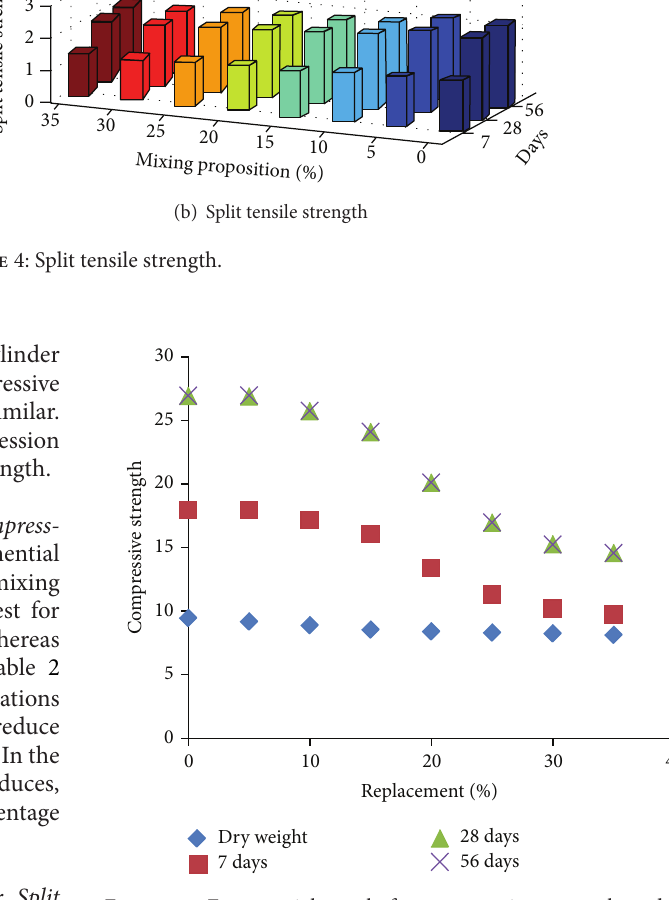
Figure 5: Exponential graph for compressive strength and dry